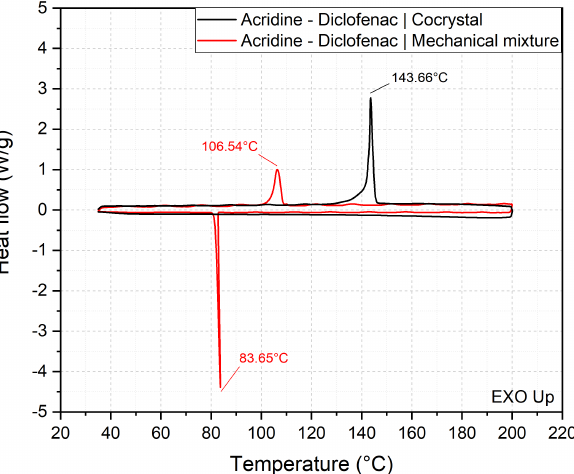
Figure 3. DSC curve of the novel cocrystal structure (black) compared to the one relative to the simple mechanical mixture of acridin and diclofenac